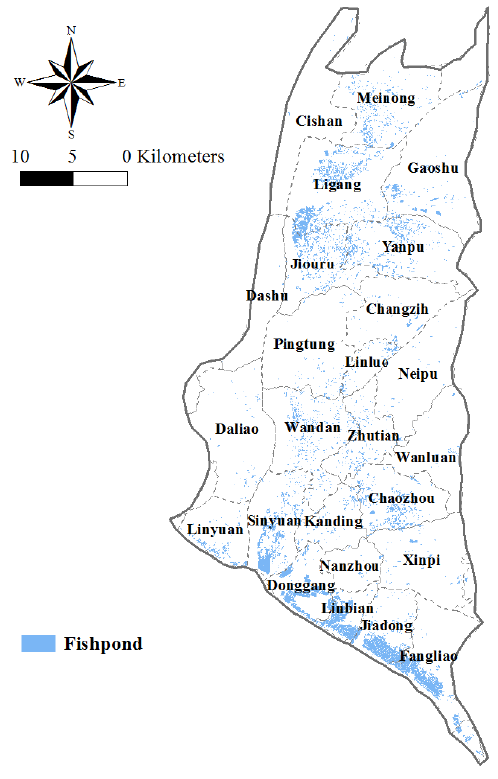
Figure 9. Fishpond locations in the study area.